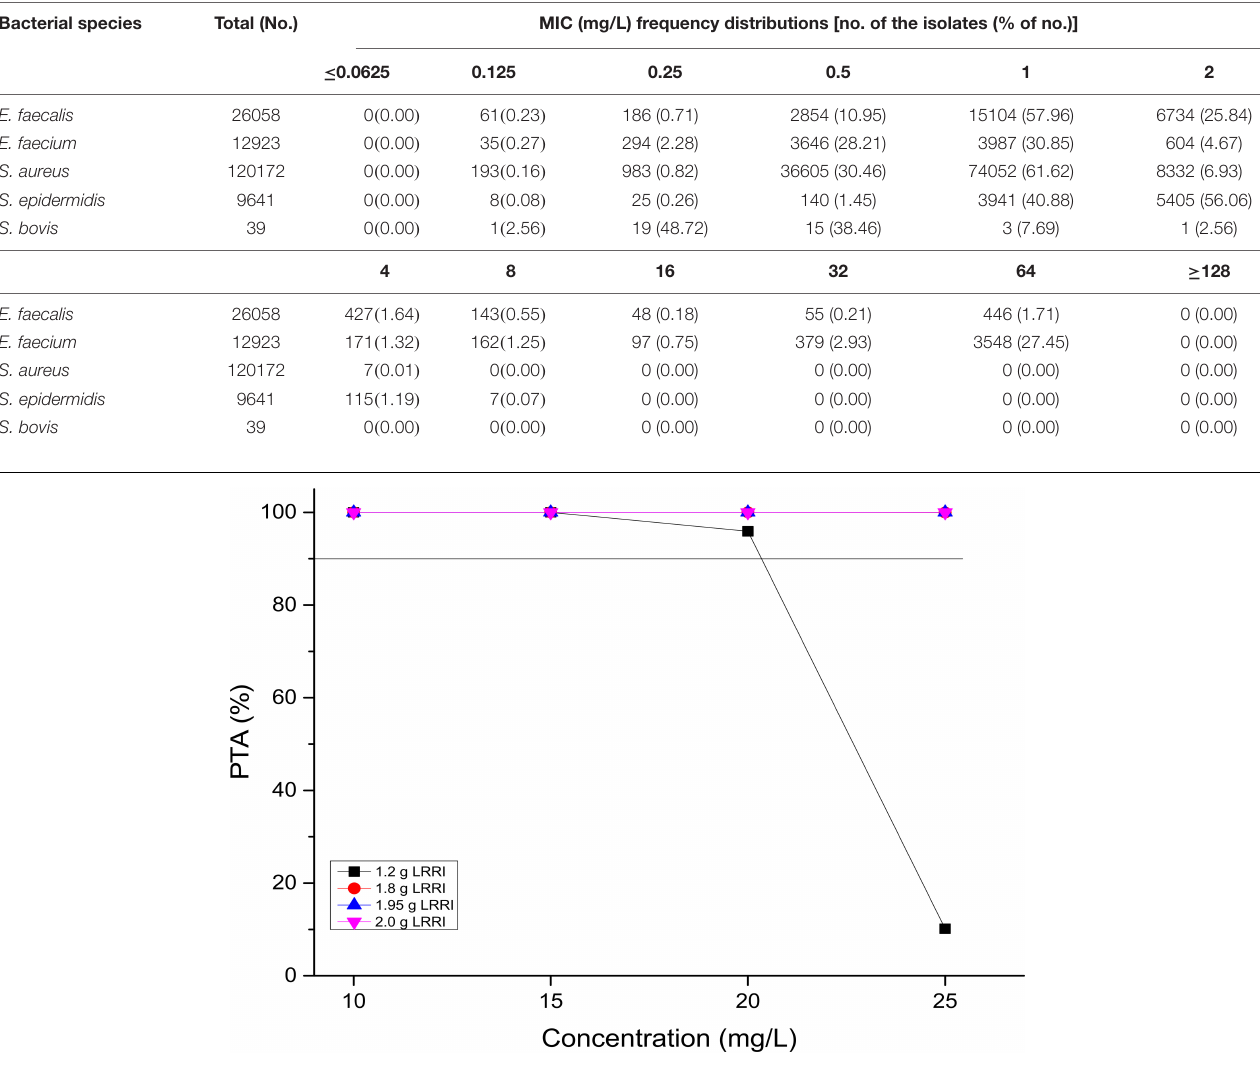
TABLE 3 | MIC frequency distributions of isolates for the targeted bacterial species. Bacterial species Total